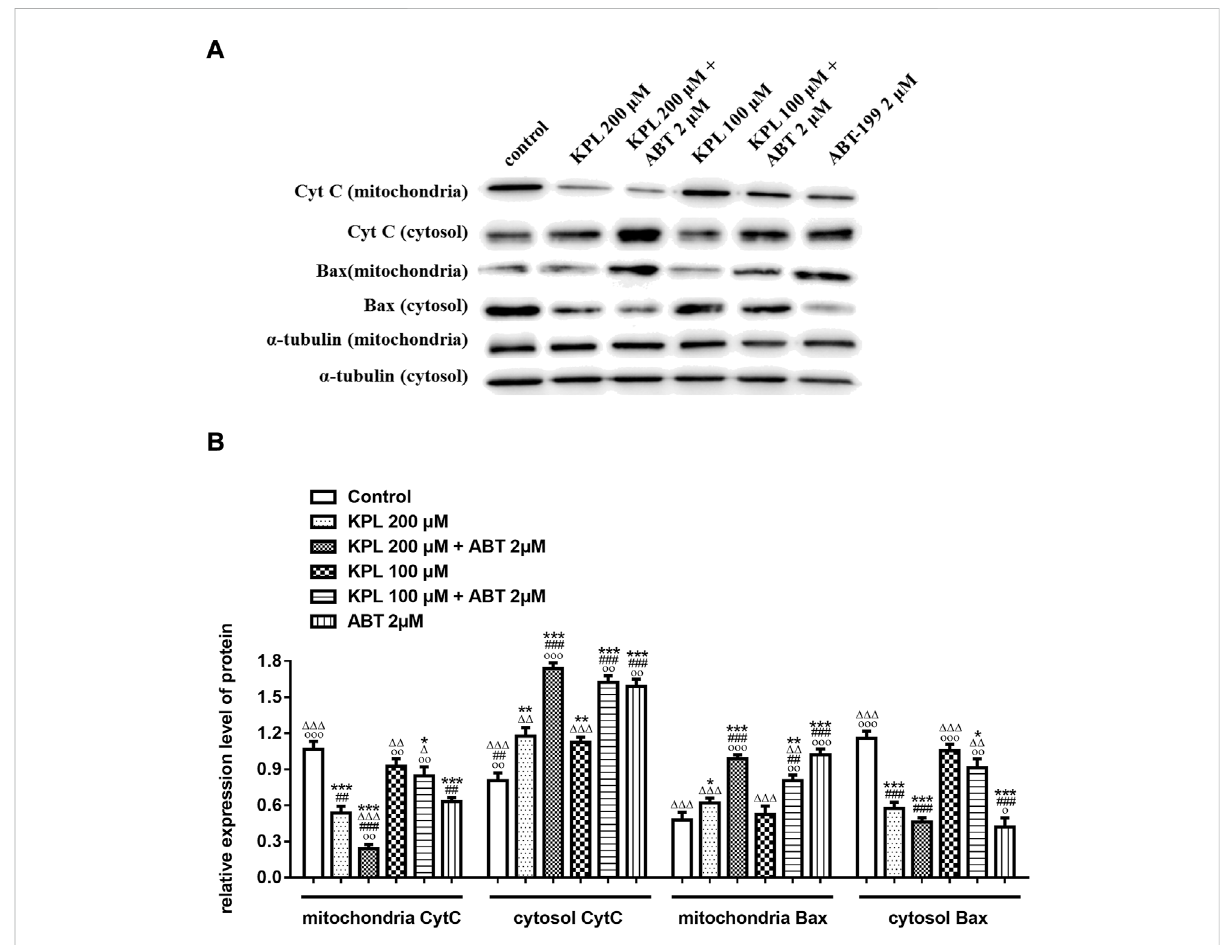
The effects of KPL combined with ABT-199 on cytochrome C release and Bax translocation in HepG2 cells were detected in mitochondria and cytoplasmic proteins by Western blot assay. (A) The expression levels of cytochrome C release and Bax in mitochondria and cytoplasmic were examined by western blotting analysis. α -tubulin was used as the internal control. (B) The relative expressionlevels ofcytochrome C release and Bax in the mitochondria and the cytoplasm. α -tubulin was used as the internal control for relative expression of